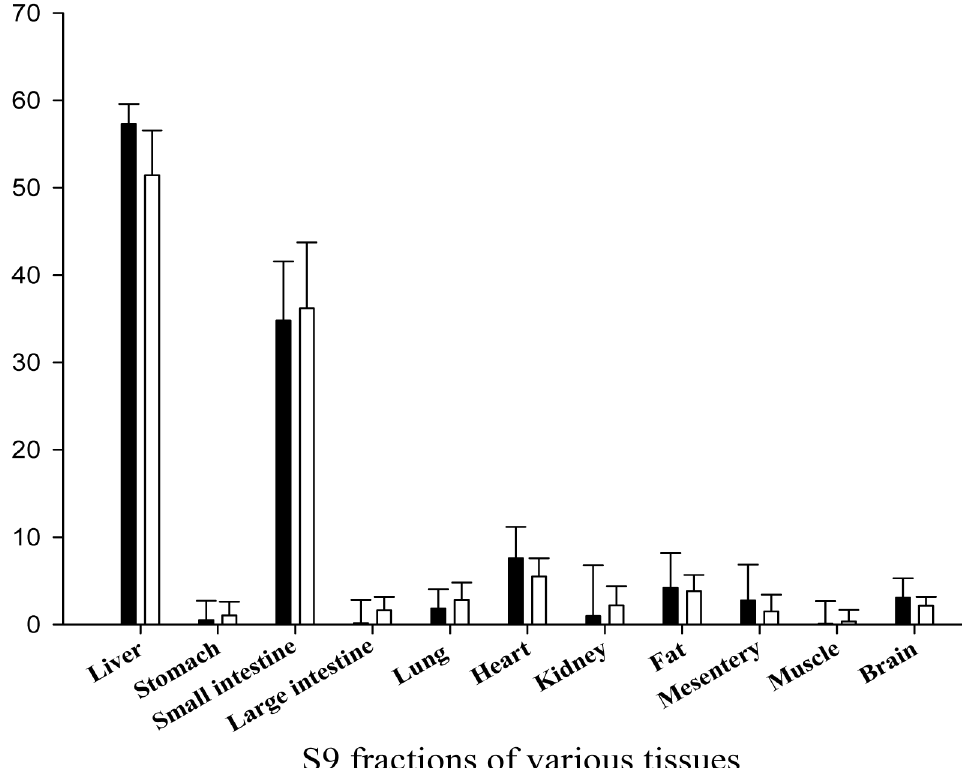
Fig 3. Mean values for the disappearance of α -MG after spiking 1 ( & ) or 20 ( □ ) μ g/mL of α -MG into S9 fractions of various tissues from mice. Bars represent